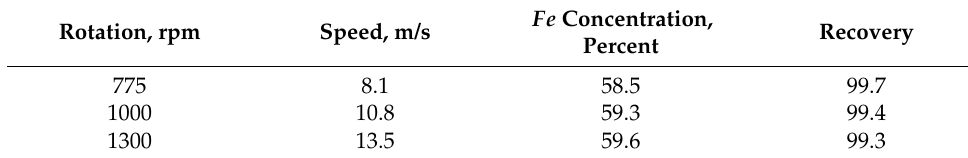
Table 2. Artificial mix–magnetic separation